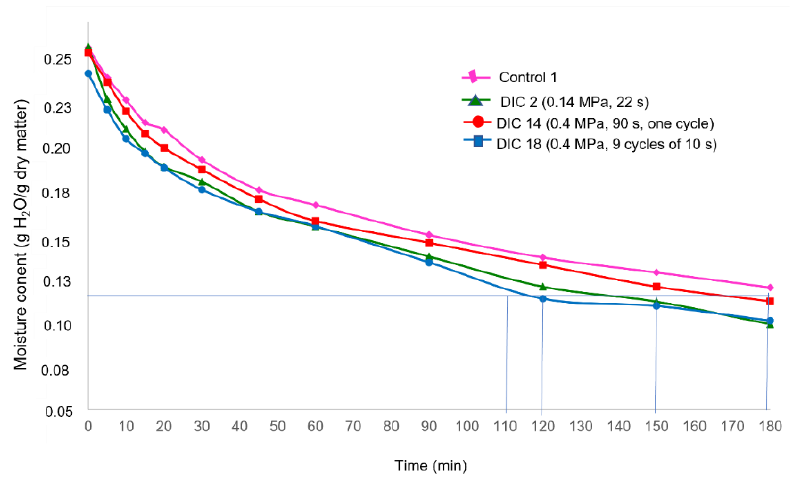
Figure 3. Drying curves of maize kernels W = f(t): Control and DIC-CAD (P = 0.14 MPa and t = 22 s; P = 0.4 MPa and t = 90 s and P = 0.4 MPa and t = 90 s divided into nine cycles of 10 s).